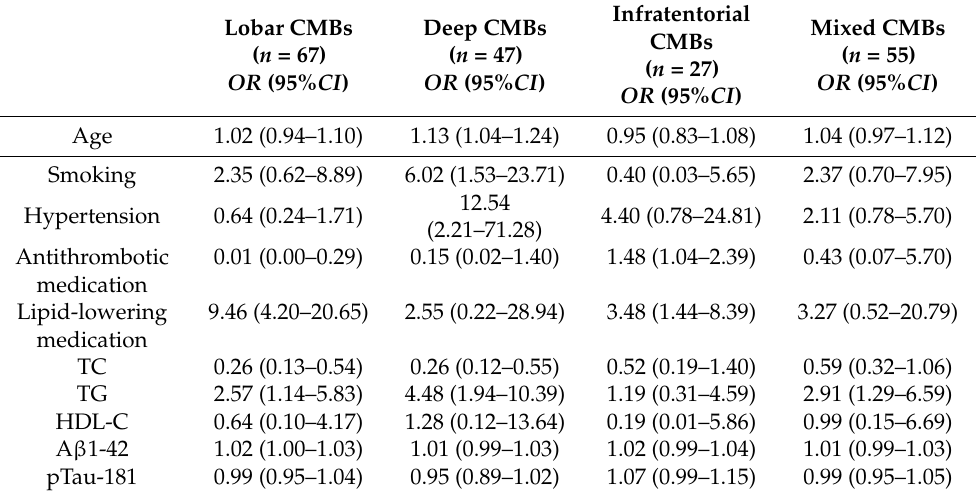
Table 4. Multivariate analysis results of the risk factors for CMBs in different